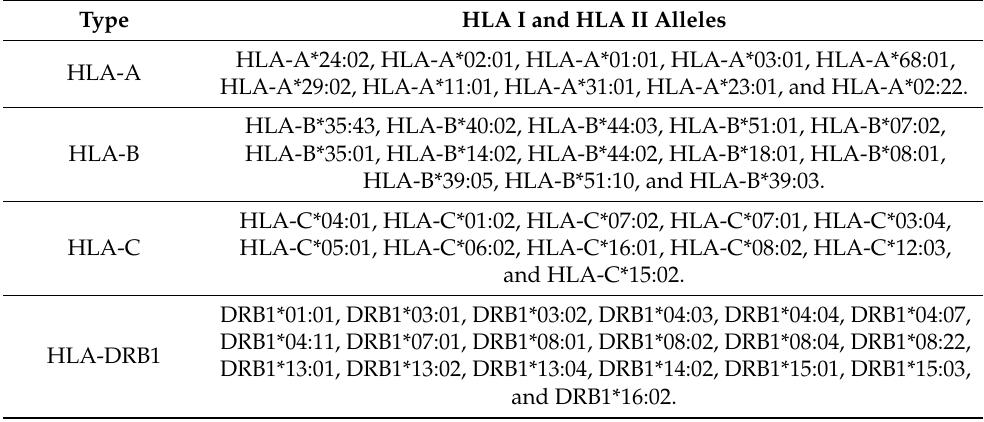
Table 8. HLA I and HLA II alleles used in this study for T-cell epitope prediction.